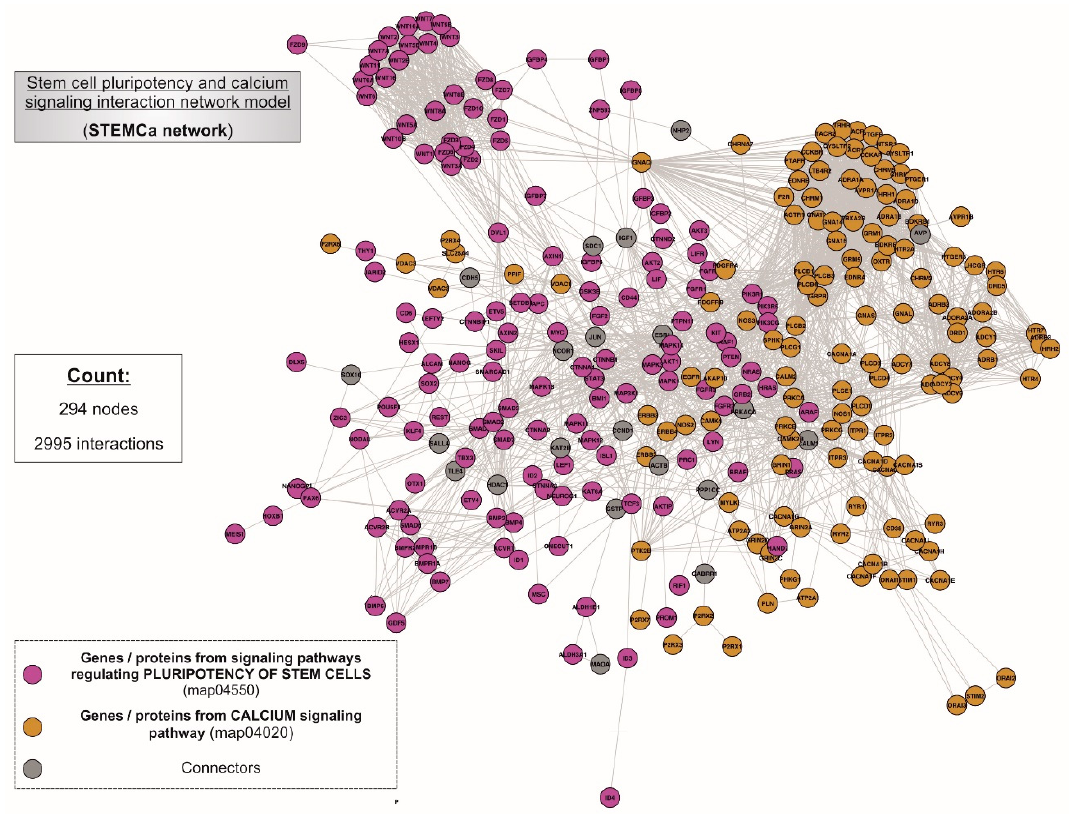
Figure 2. “STEMCa” interactome. General landscape of interactions between the genes/proteins of stem cell pluripotency (map04550) and calcium signaling (map04020) interaction network model. The present in silico network model was developed by using the STRING V10.0 database resource search tool, exclusively using ‘‘experiments’’ and ‘‘databases’’ as input options for active prediction methods and a minimum confidence score of 0.400 (medium confidence).